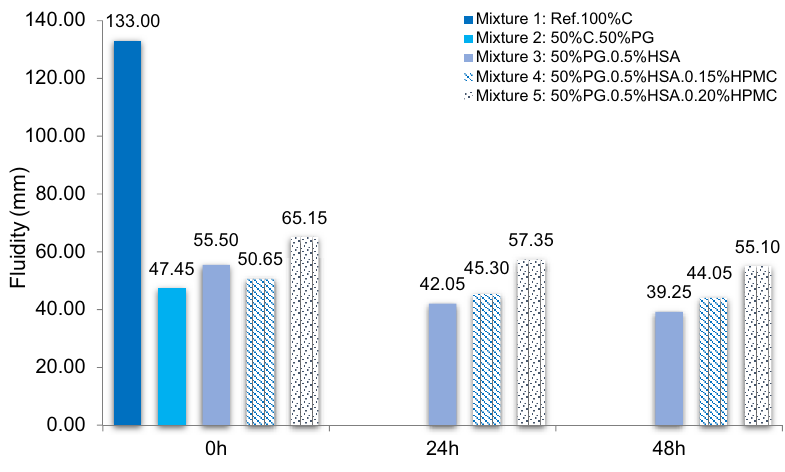
Figure 1: E ff ect of adding PG and admixtures on fl uidity over time.